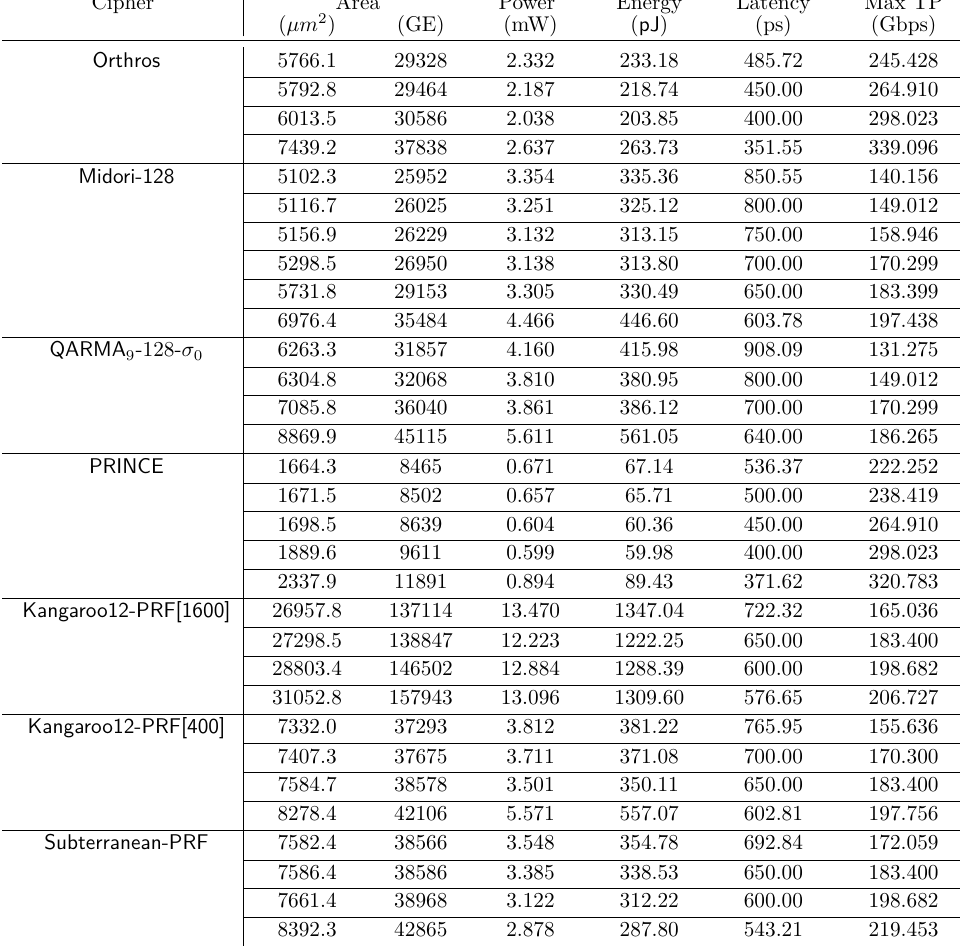
Table 17: Results for the Nangate 15nm library. Power measured at 10